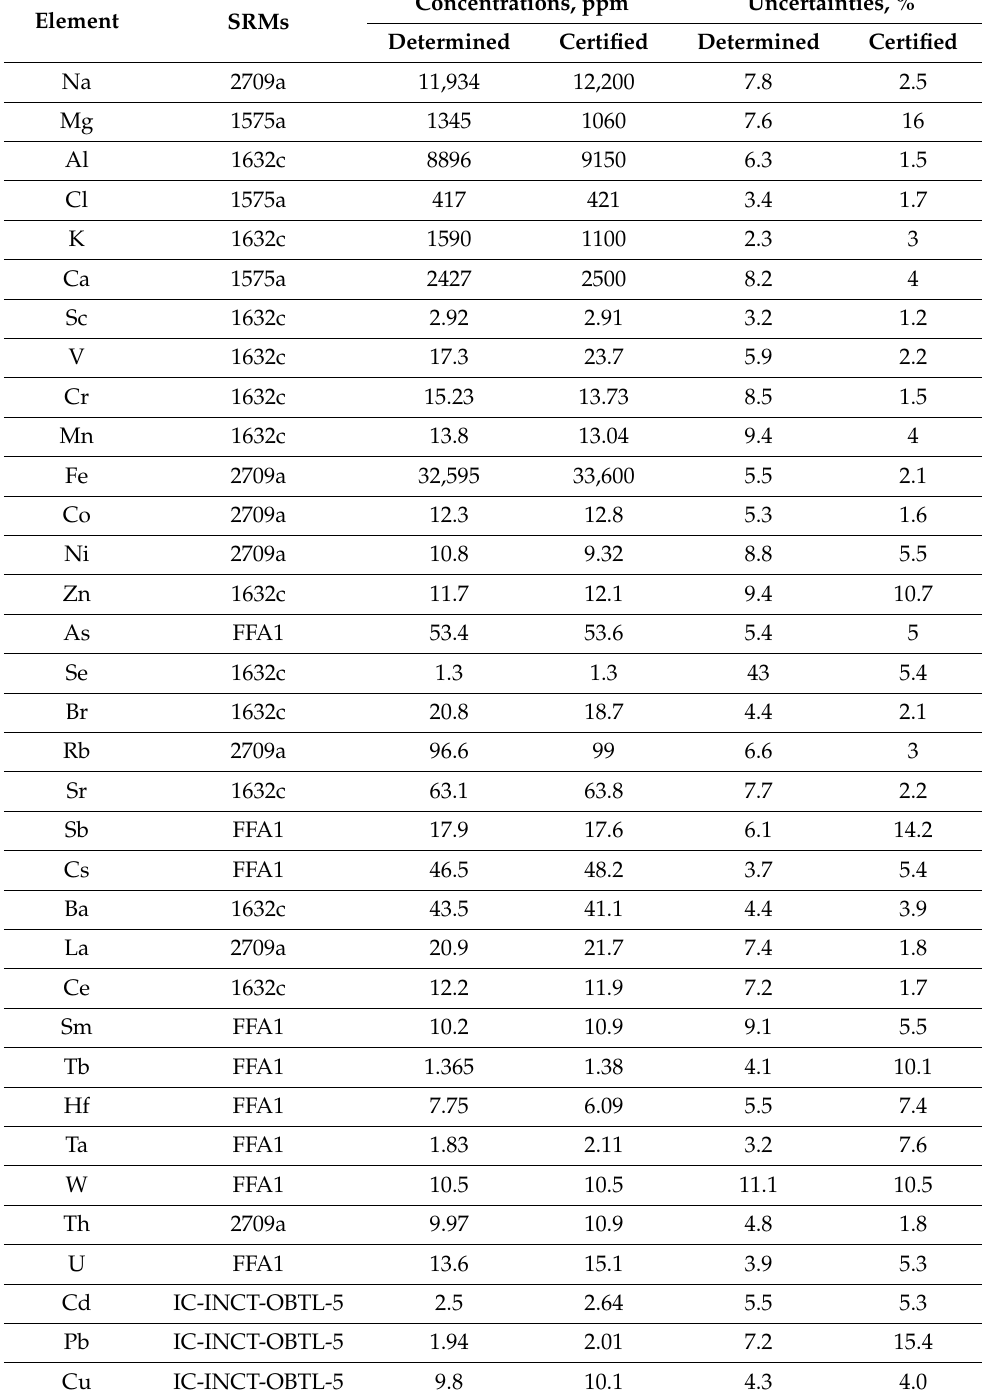
Table 1. Quality control of neutron activation analysis and atomic absorption spectrometry.